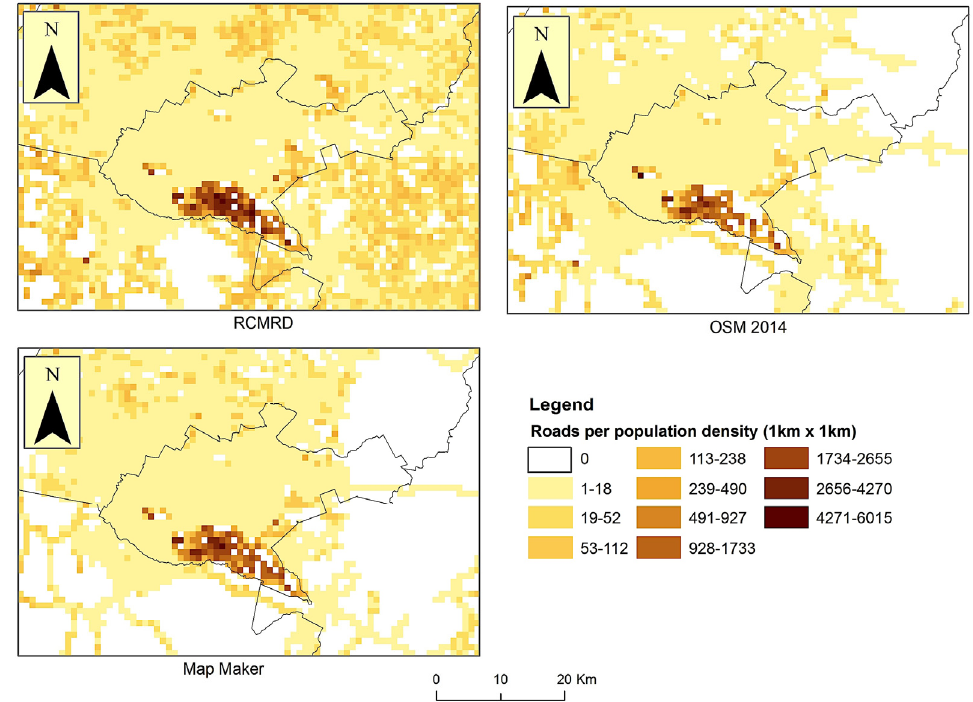
Figure 10. Road coverage in relation to population density per km 2 .